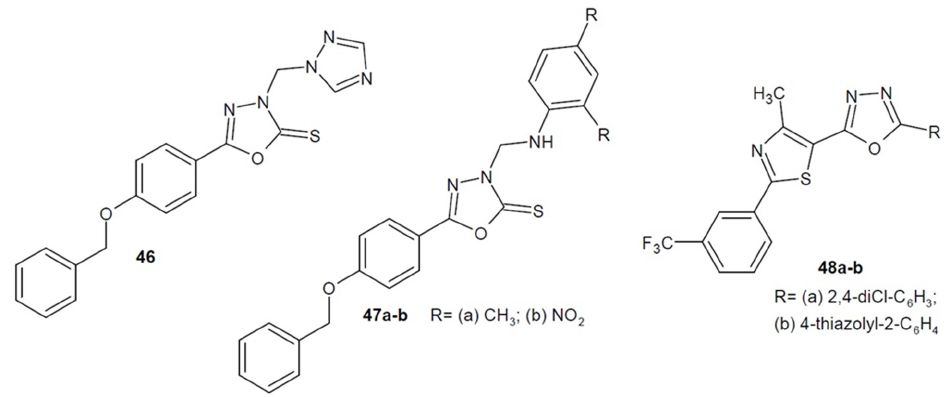
Figure 17. 1,3,4-oxadiazole derivatives with antifungal activity (part 2).